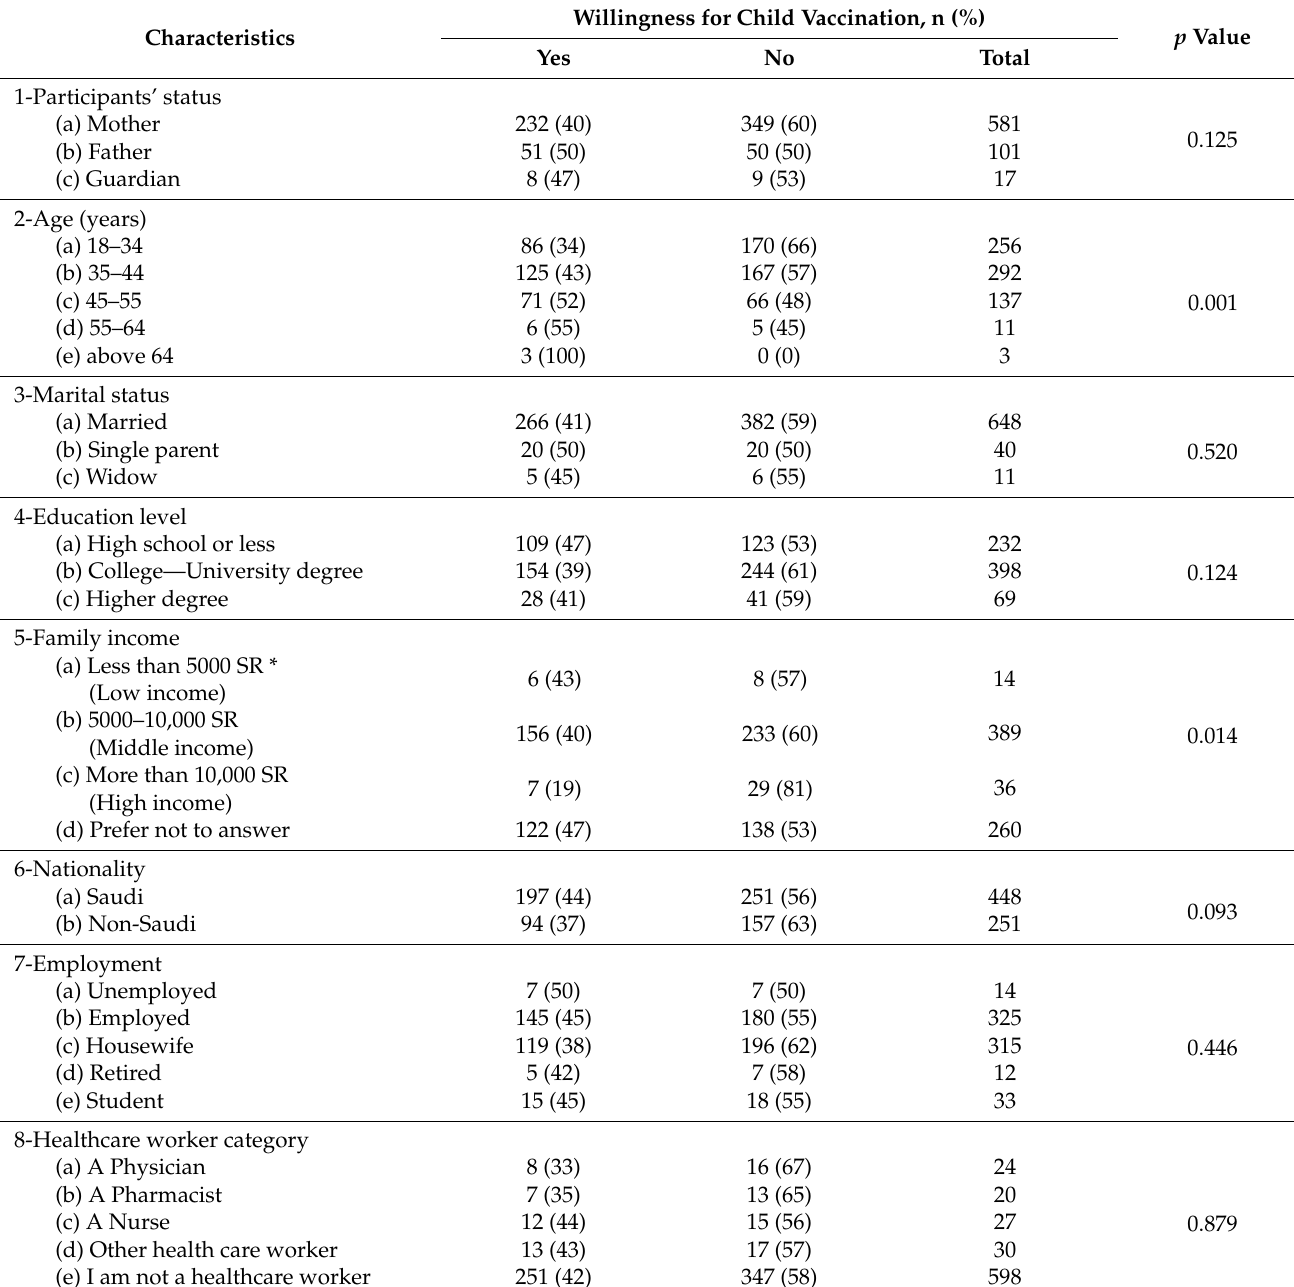
Table 3. Comparison of sociodemographic characteristics with willingness for child